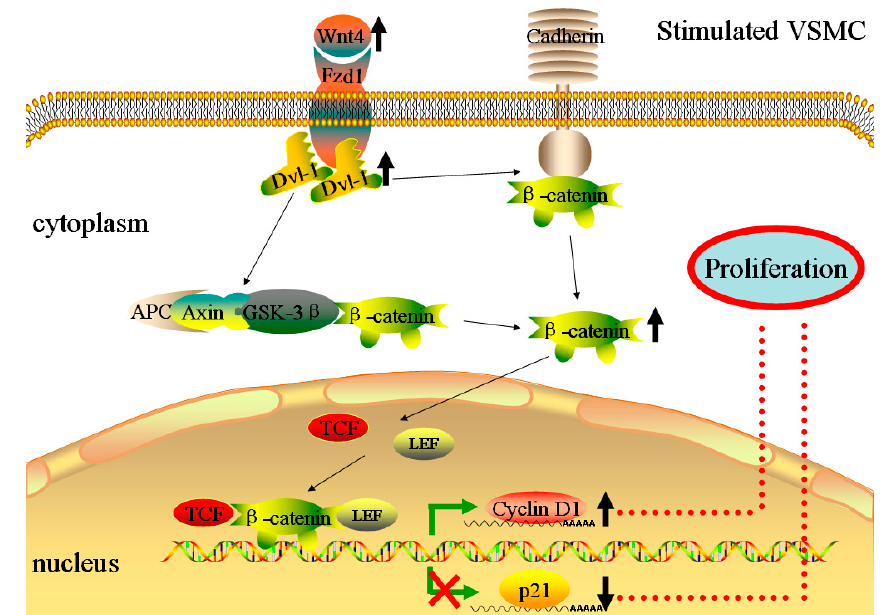
Figure 7. The mechanism of stimulated VSMC proliferation through the Wnt4/Dvl-1/ β -catenin signaling pathway. External stimuli could increase the expression of Wnt4 and the elevated Wnt4 activate the cytosolic protein Dvl-1 by interacting with its receptor, Frizzled receptor 1 (Fzd-1). Then, the activated Dvl-1 may influence the functional state of the complex APC-Axin-GSK-3 β (consisting of adenomatous polyposis coli (APC), Axin, and glycogen synthase kinase-3 β ) and cadherins, resulting in the rapid increase of free β -catenin in the cytoplasm. The free β -catenin would translocate to the nucleus and bind members of the T-cell factor (TCF)/lymphoid enhancer factor (LEF) transcription factor family, regulating the expressions of downstream signaling molecules, including p21 and Cyclin D1.